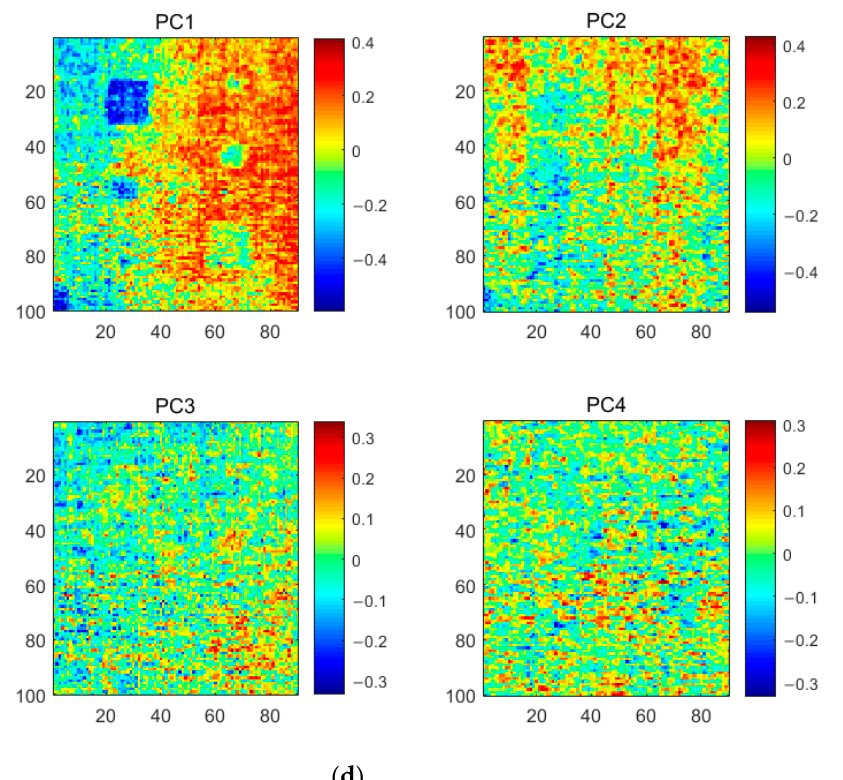
Figure 14. Analysis results of CFRP Specimen 2 based on ( a ) PCT, ( b ) GPCT, ( c ) KPCT (with a Gaussian kernel whose width is set to 1/ τ = 0.2), and ( d ) GKPCT (1/ τ = 0.2 ). The value in bold indicates the maximum SNR value corresponding to the defect. Table 2. SNR values of different methods for CFRP specimen 2.